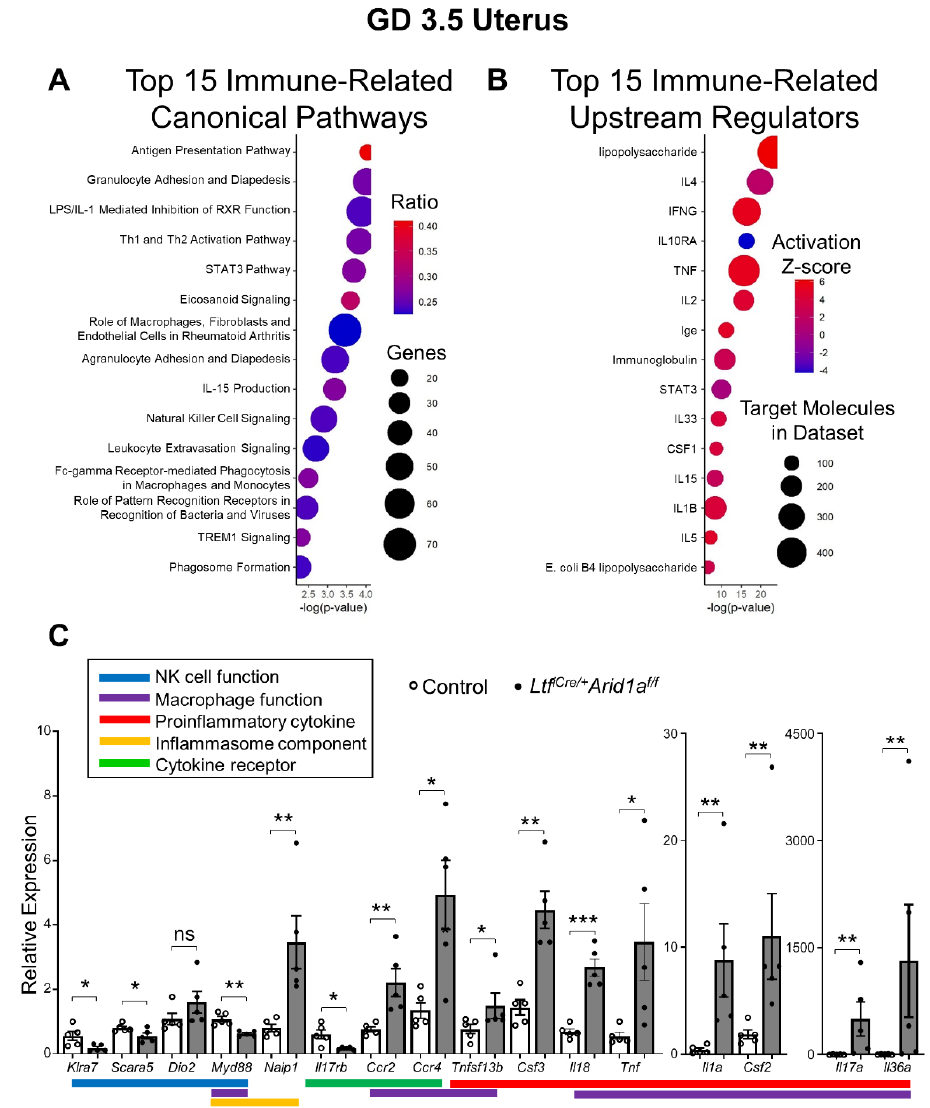
Figure 4. Ltf iCre/+ Arid1a f/f uteri exhibit immune-related gene expression changes at GD 3.5. ( A ) Ingenuity Pathway Analysis of the 4181 genes differentially expressed between Arid1a f/f and Ltf iCre/+ Arid1a f/f uteri (FDR < 0.05) identified 194 significantly enriched canonical pathways ( p < 0.05). The plot shows the top 15 immune-related pathways from this list based on their corresponding p - values and also displays ratios (genes in current set/total genes in pathway) and number of genes